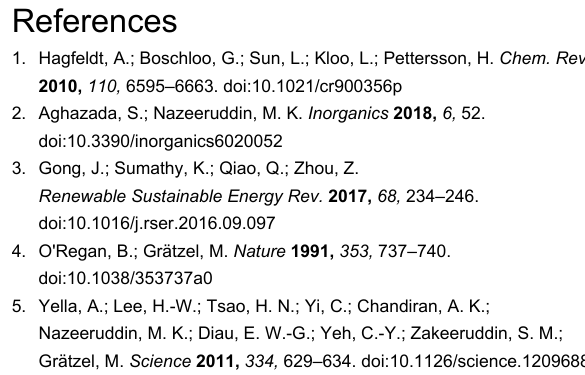
DSC stability tests; Figure S6: Dependence of V OC of DSCs on